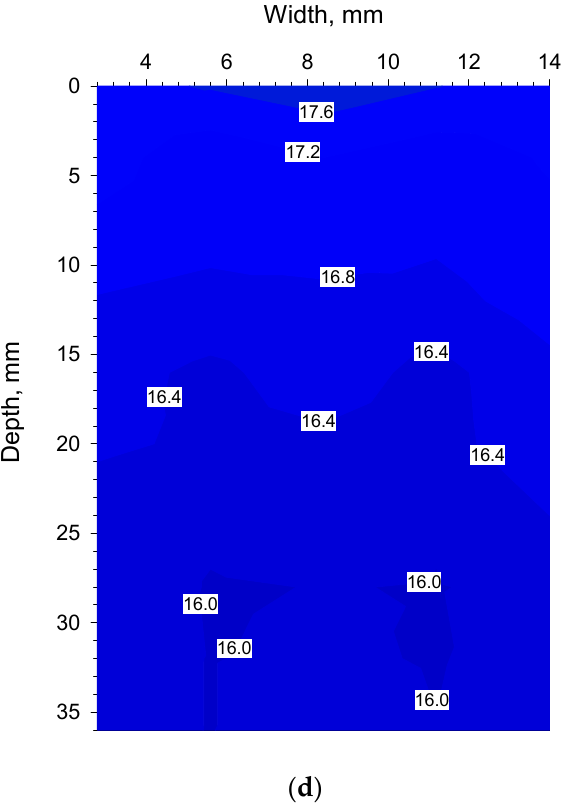
Figure 2. ( a ). Olive oil–water experiment, germanium window monitored after 0 s. ( b ). Olive oil–water experiment, soda-lime glass window monitored after 0 s. ( c ). Olive oil–water experiment, germanium window monitored after 180 s. ( d ). Olive oil–water experiment, soda-lime glass window monitored after 180 s.